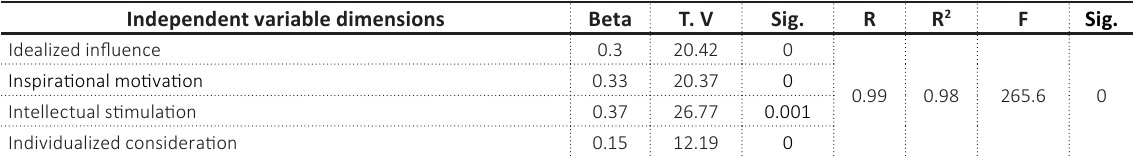
Table 3. Relationship between transformational leadership dimensions and job satisfaction